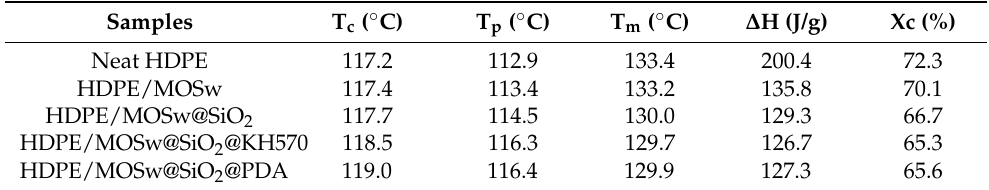
DSC data for HDPE, HDPE/MOSw, HDPE/MOSw, HDPE/MOSw@SiO 2